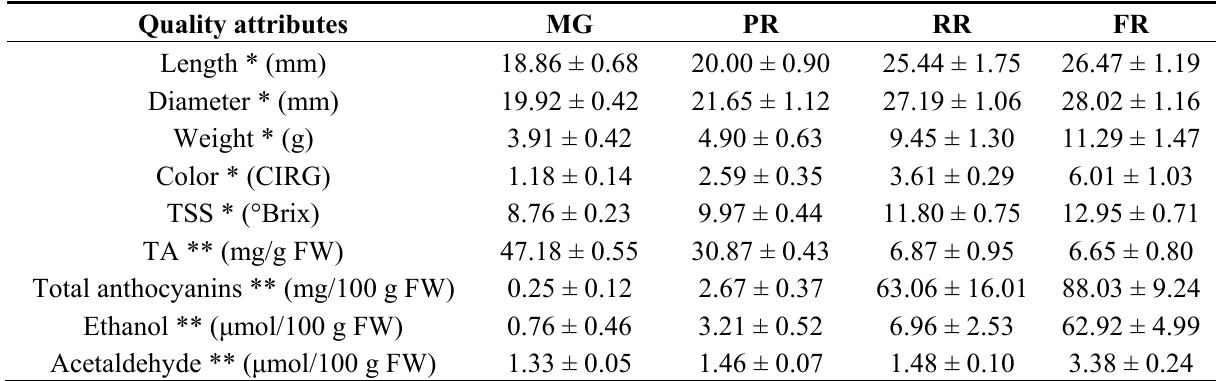
Table 1. Quality attributes of “Biqi” fruit at mature green (MG), pink ripe (PR), red ripe (RR), and full ripe (FR)